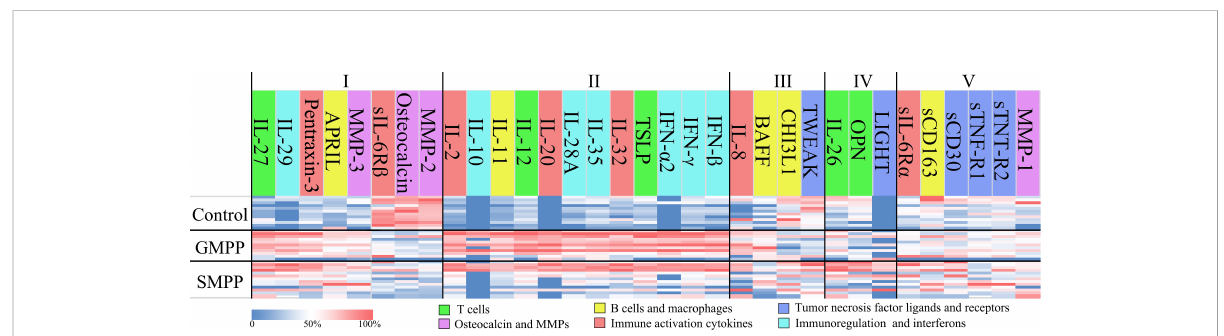
FIGURE 1 Cytokine pro fi les in the GMPP, SMPP, and Control groups. The cytokines were clustered by statistical analysis between groups and colored by their main deduced functions. Clusters I and II represent the cytokines that signi fi cant regulated in both MPP groups compared to control group, the cytokines were divided into the ones with (II) or with no (I) signi fi cant differences (p < 0.05) between MPP groups; Cluster III represent the cytokines that signi fi cant regulated in GMPP but not SMPP group compared to control group; Cluster IV represent the cytokines that signi fi cant regulated in SMPP but not GMPP group compared to control group; Cluster V represent the cytokines that did not show signi fi cant differences between groups (p <